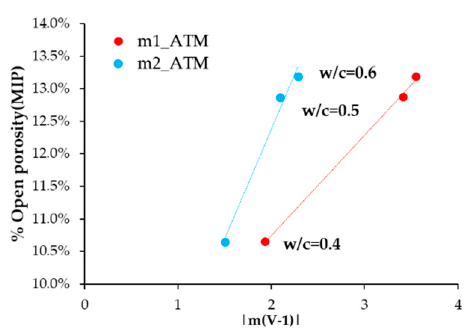
Figure 12. Correlation between the open porosity percentage (MIP) and slopes m1 and m2.